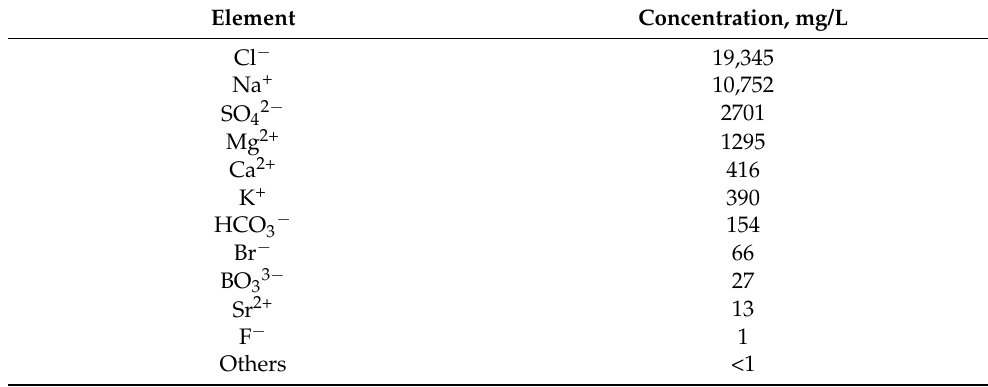
Table 1. Concentration of ionic species in seawater from the coast of the B í oB í o Region in Chile [19].